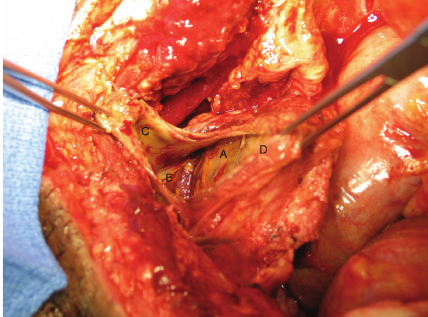
Figure 3: Intraoperative photo of bladder injury. A: necrotic tissue. B: trigone. C: anterior bladder wall. D: posterior bladder